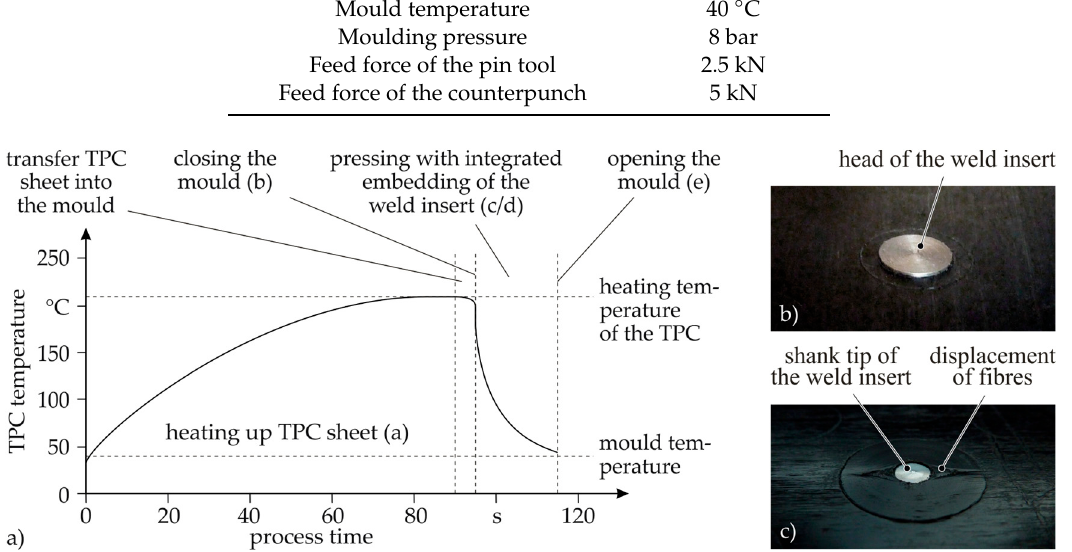
Table 1. Manufacturing parameters of the process-integrated embedding of weld inserts in TPC.